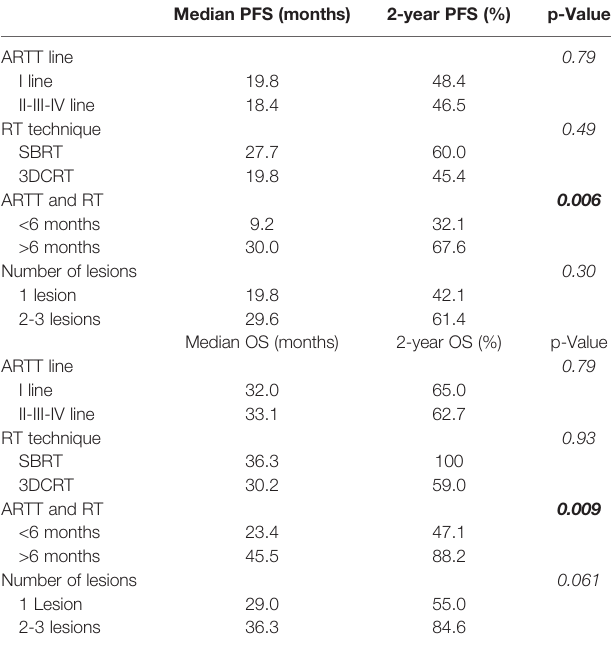
TABLE 3 | Univariate